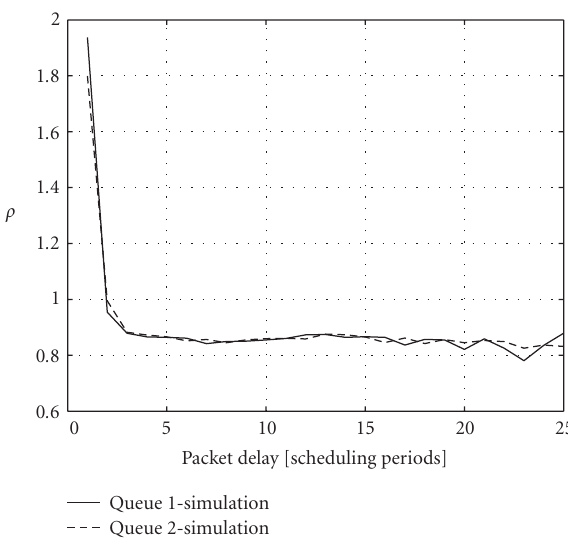
Figure 4: Distribution of the packet delay. Figure 5: Values of ρ obtained by